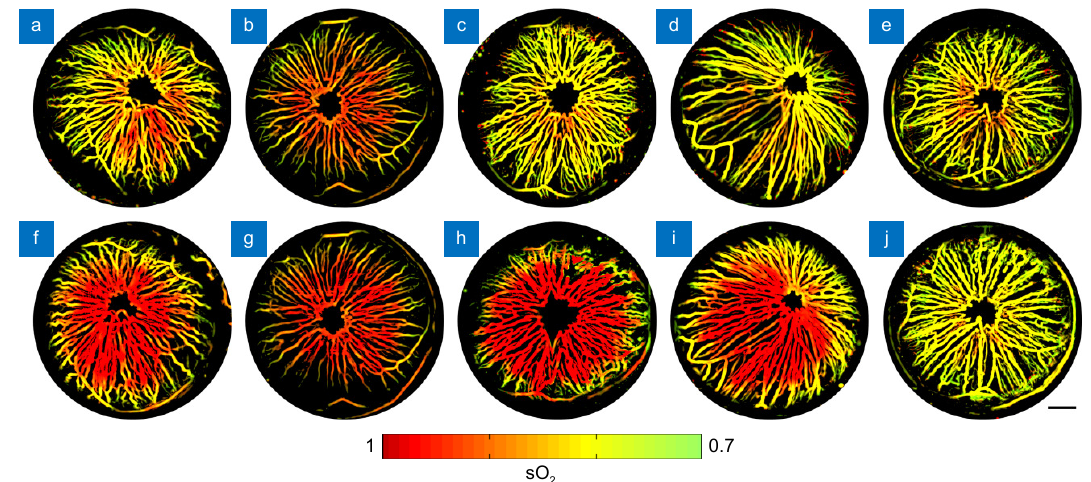
Fig. 6 | The sO 2 maps of all mice before and after burn. Scale